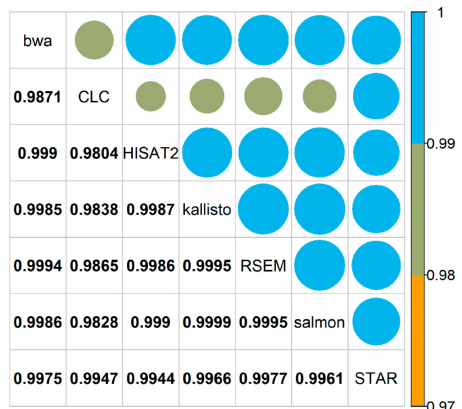
Figure 4. Mapper comparison based on raw count distributions. Graphical representation of the computed R v values based on the correlation matrices of the unfiltered raw count tables generated by all mappers for all samples from both accessions. Values close to 1 indicate high similarity. The color and shape scales were adjusted to visualize the small di ff erences between the R v coe ffi cients.